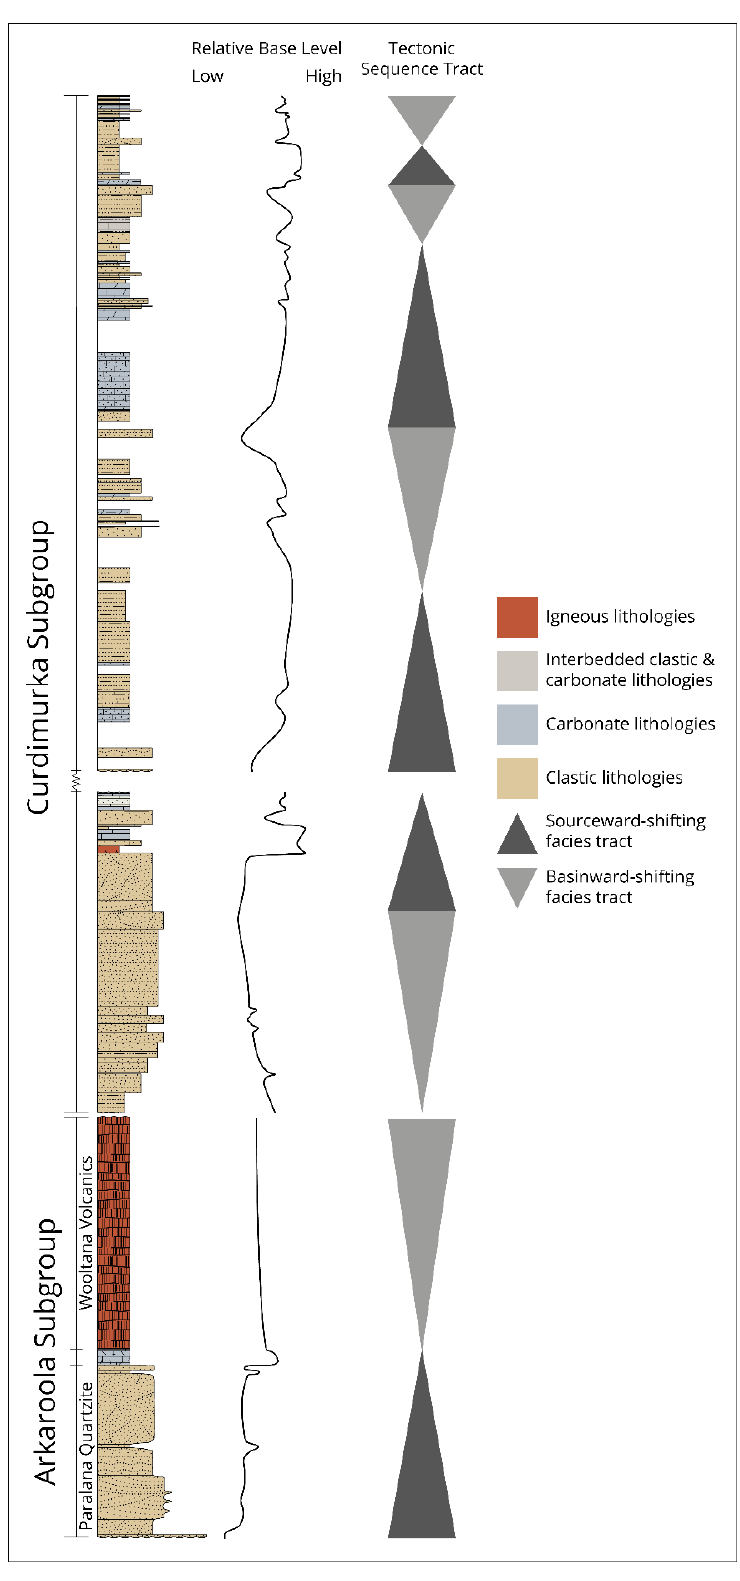
Figure 3. Simplified (composite) stratigraphic log of the Callanna Group based on the type sections from Arkaroola and the Willouran Ranges. This shows the generalised stratigraphy representative of the Callanna Group across the Adelaide Superbasin. Relative base level utilises further information from Mackay [27] and Preiss [24,25]. Tectonic successions follow the terminology of Matenco and Haq [53]. Sourceward-shifting facies tracts are where accommodation space was created faster